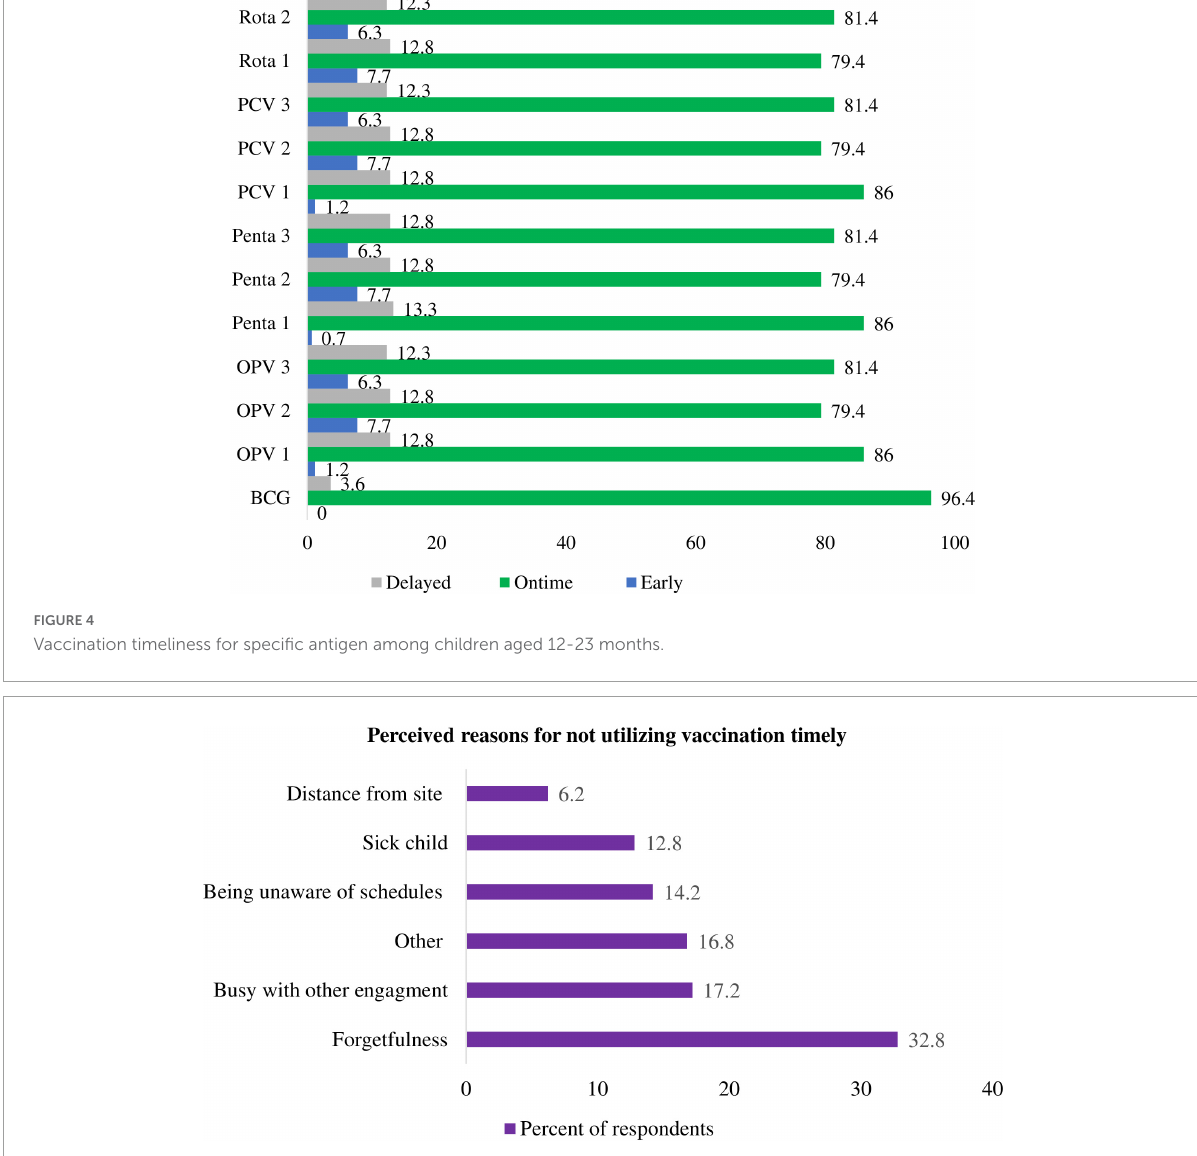
FIGURE5 Perceived reasons for not vaccinating children